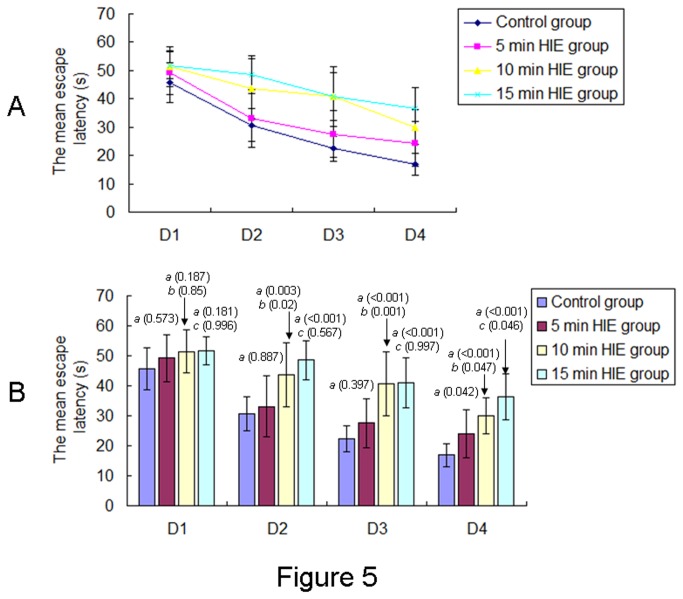
The mean EL of offsprings over 4-day training periods in the Morris water maze test.
A: The learning curves for the offspring rats from different groups over the course of 4-day training periods in the Morris water maze test were showed. 
B: The mean EL of the offspring rats from different groups (control group, n= 12; 5 min HIE group, n= 13; 10 min HIE group, n= 12; 15 min HIE group, n= 10) were expressed as mean ± S.D.. a: compared with the control group; b: compared with the 5 min HIE group; c: compared with the 10 min HIE group. The P values were showed in the bracket.